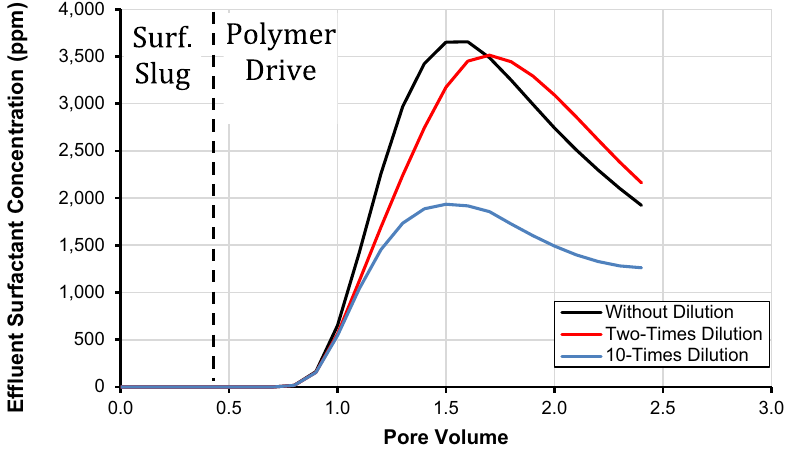
Figure 8. Effect of injected chemical flood salinity on effluent surfactant concentration using the developed